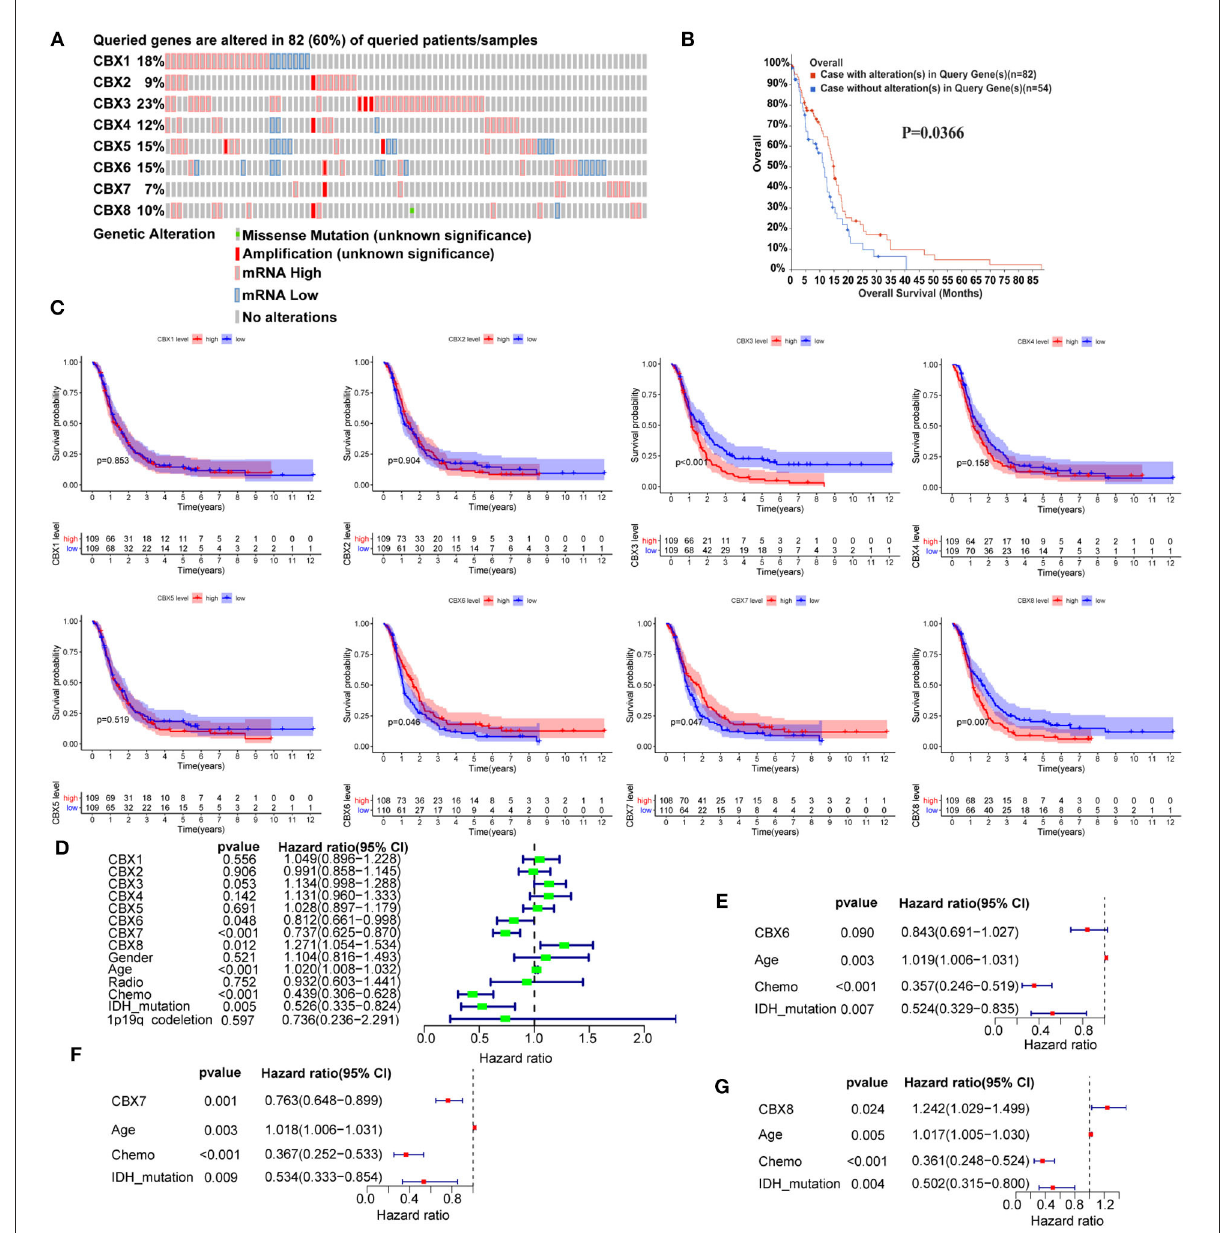
FIGURE5 The prognostic value of CBX family in GBM patients. (A) The genetic mutation of CBX members in GBM patients was analyzed on cBioPortal (TCGA, Firehose Legacy). The z-scores of mRNA expression relative to diploid samples were set at 1.5. Except for the gray region (No alteration), the other colors represented different genetic mutations in these patients. (B) The prognostic value of alterations in CBX genes was analyzed by Kaplan-Meier analysis on cBioPortal. (C) The correlation between mRNA expression and GBM patients’ survival was explored by Kaplan-Meier analysis in CGGA data. The red dash represented high mRNA expression, and the blue meant low expression. (D) The univariate Cox survival analysis was conducted to screen out the significant single factors that contributed to the survival of GBM patients. The p -value threshold was 0.5. (E–G) Further multivariate Cox survival analysis was used to confirm the independent prognostic values of the above significant single factors. The above Kaplan-Meier, univariate, and multivariate survival analyses using R software with the “survival” and “survminer” packages.